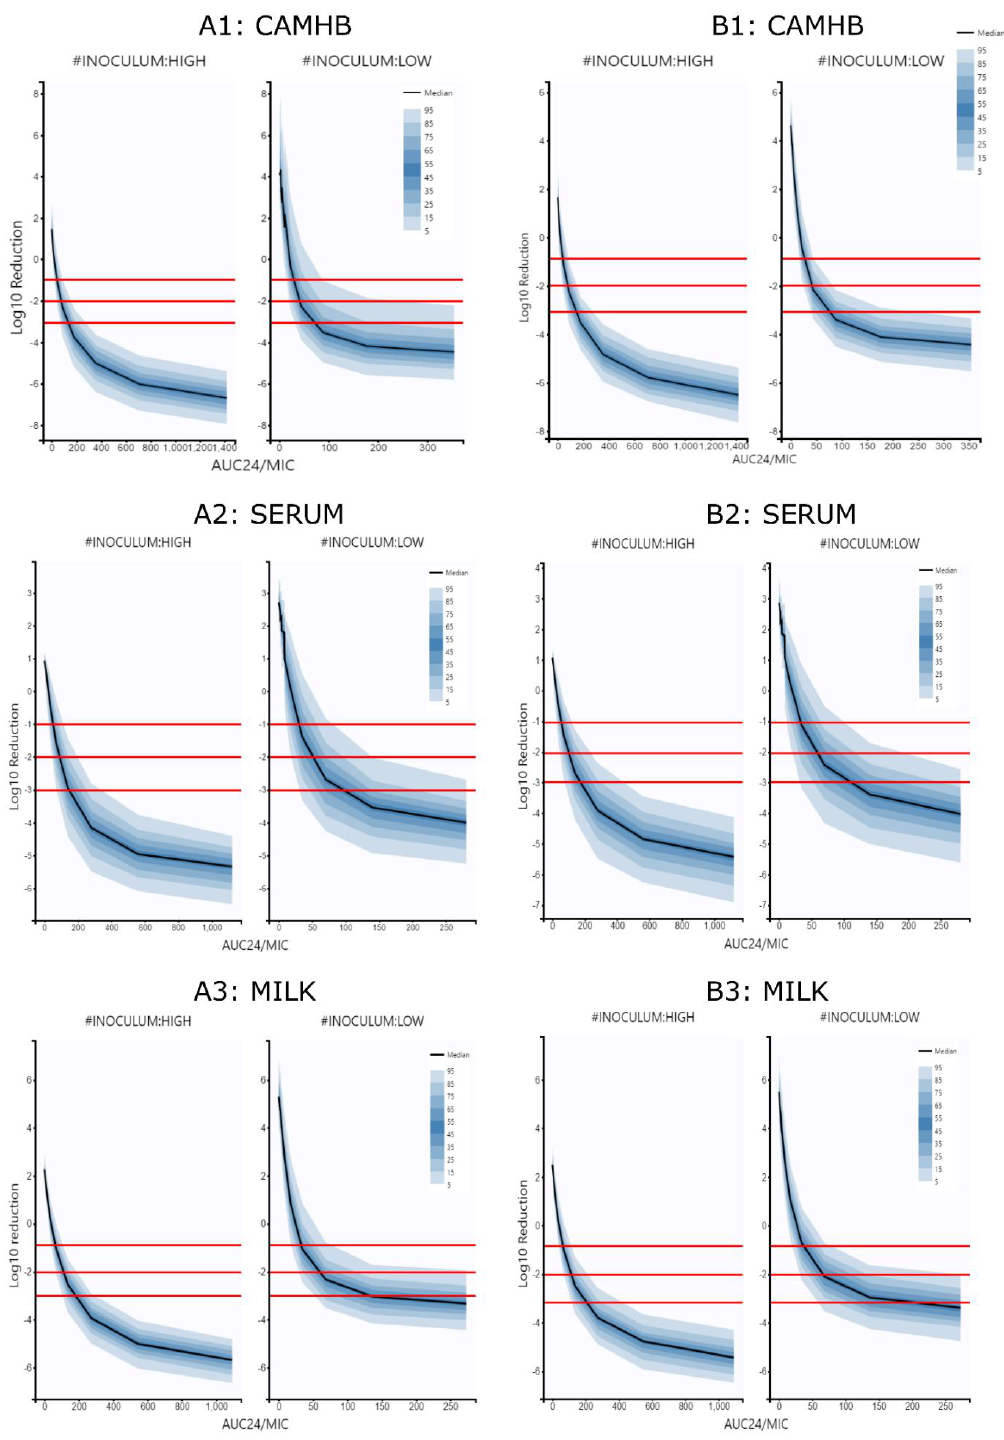
Figure 3. Plots of simulated log 10 reduction data stratified by inoculum size versus fAUC 24 / MIC values necessary to achieve − 3, − 2 and − 1 log 10 reduction from the initial population. ( A1 ): Data from CAMHB after modeling and simulation with one population bacterial model; ( A2 ): Data from serum after modeling and simulation with one population bacterial model; ( A3 ): data from milk after modeling and simulation with one population bacterial model; ( B1 ): Data from CAMHB after modeling and simulation with two population bacterial model; ( B2 ): Data from serum after modeling and simulation with two population bacterial model; ( B3 ): Data from milk after modeling and simulation with two populations bacterial model. Red horizontal lines represent − 1, − 2 and − 3 log 10 reduction as visual